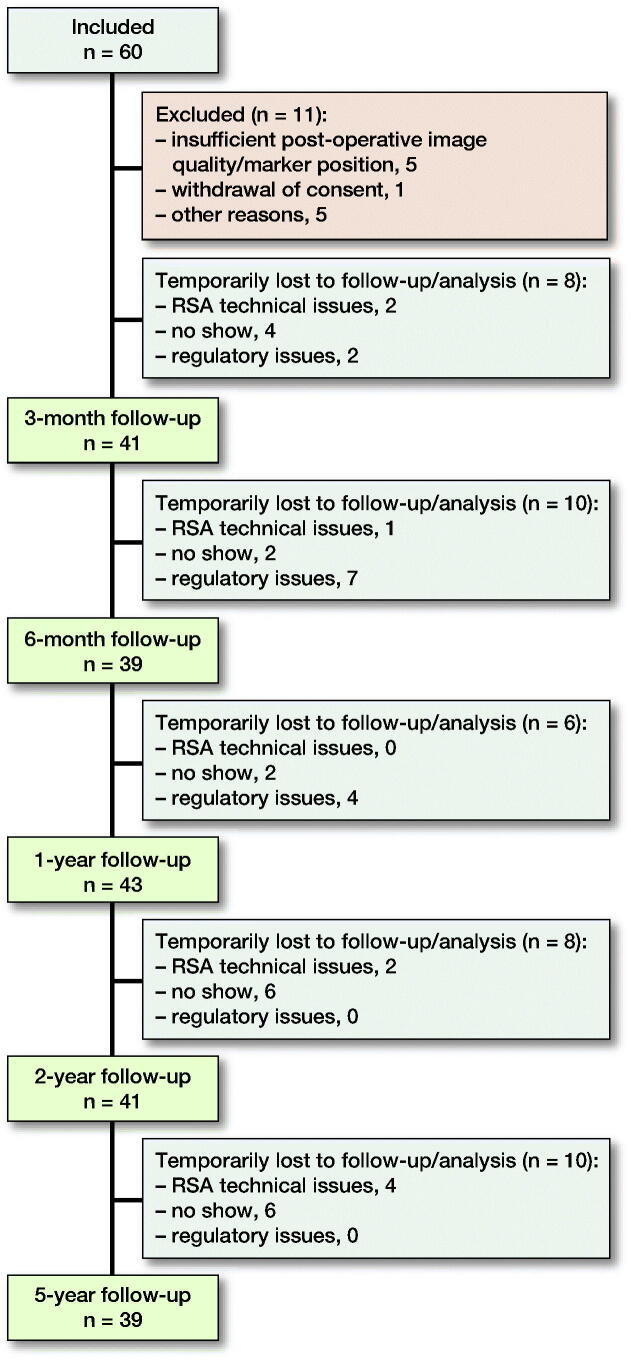
Flowchart of the 60 study participants and the number of patients at each follow-up assessment. The technical issues associated with the radiostereometric analysis included marker occlusion, caused by unusual positioning of ovarian/testicular radiation protection, and insufficient image quality.